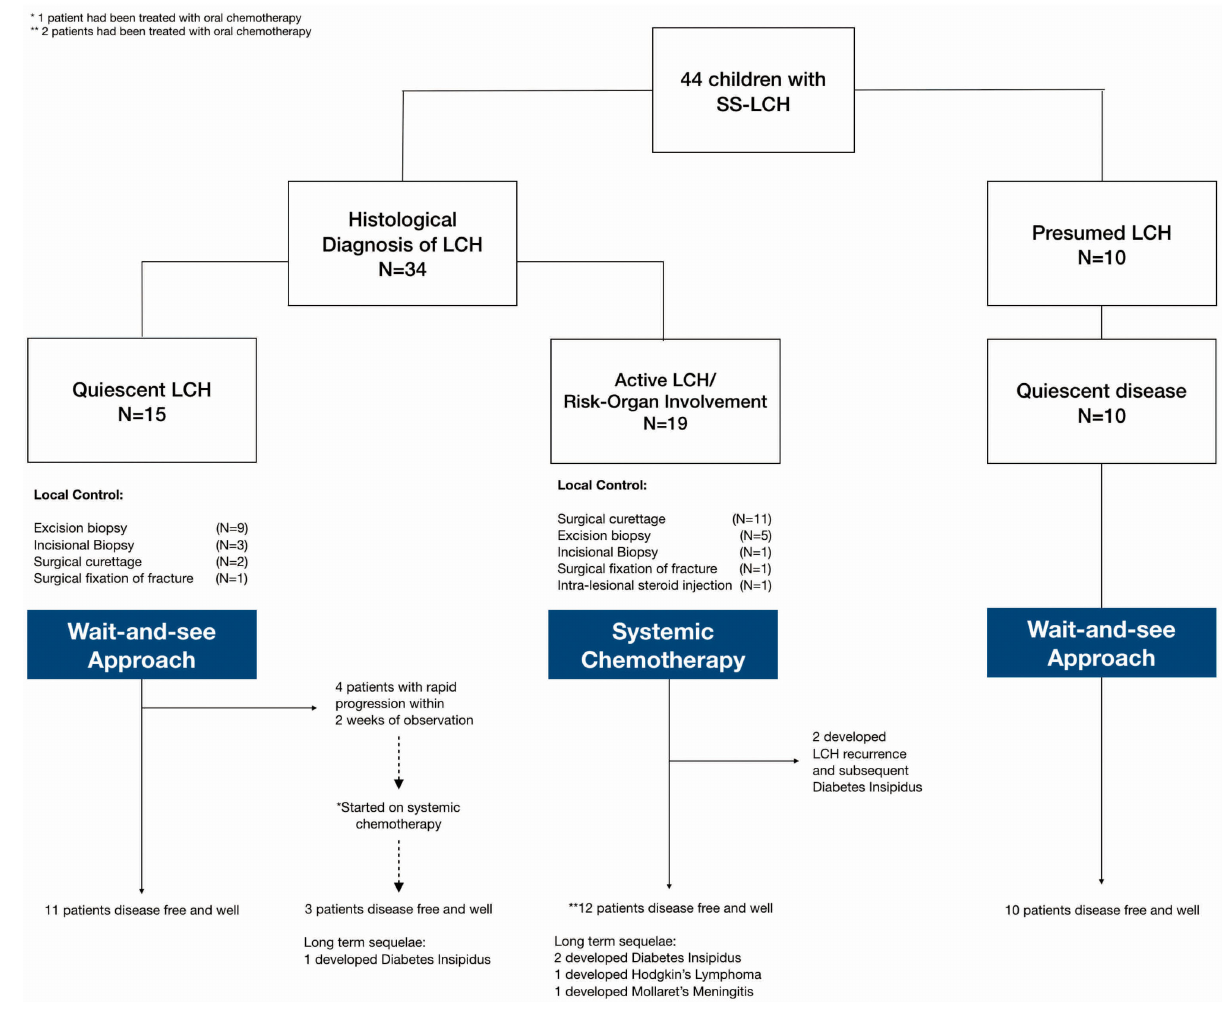
FIGURE 1 | Description of patient groups, interventions and outcomes.